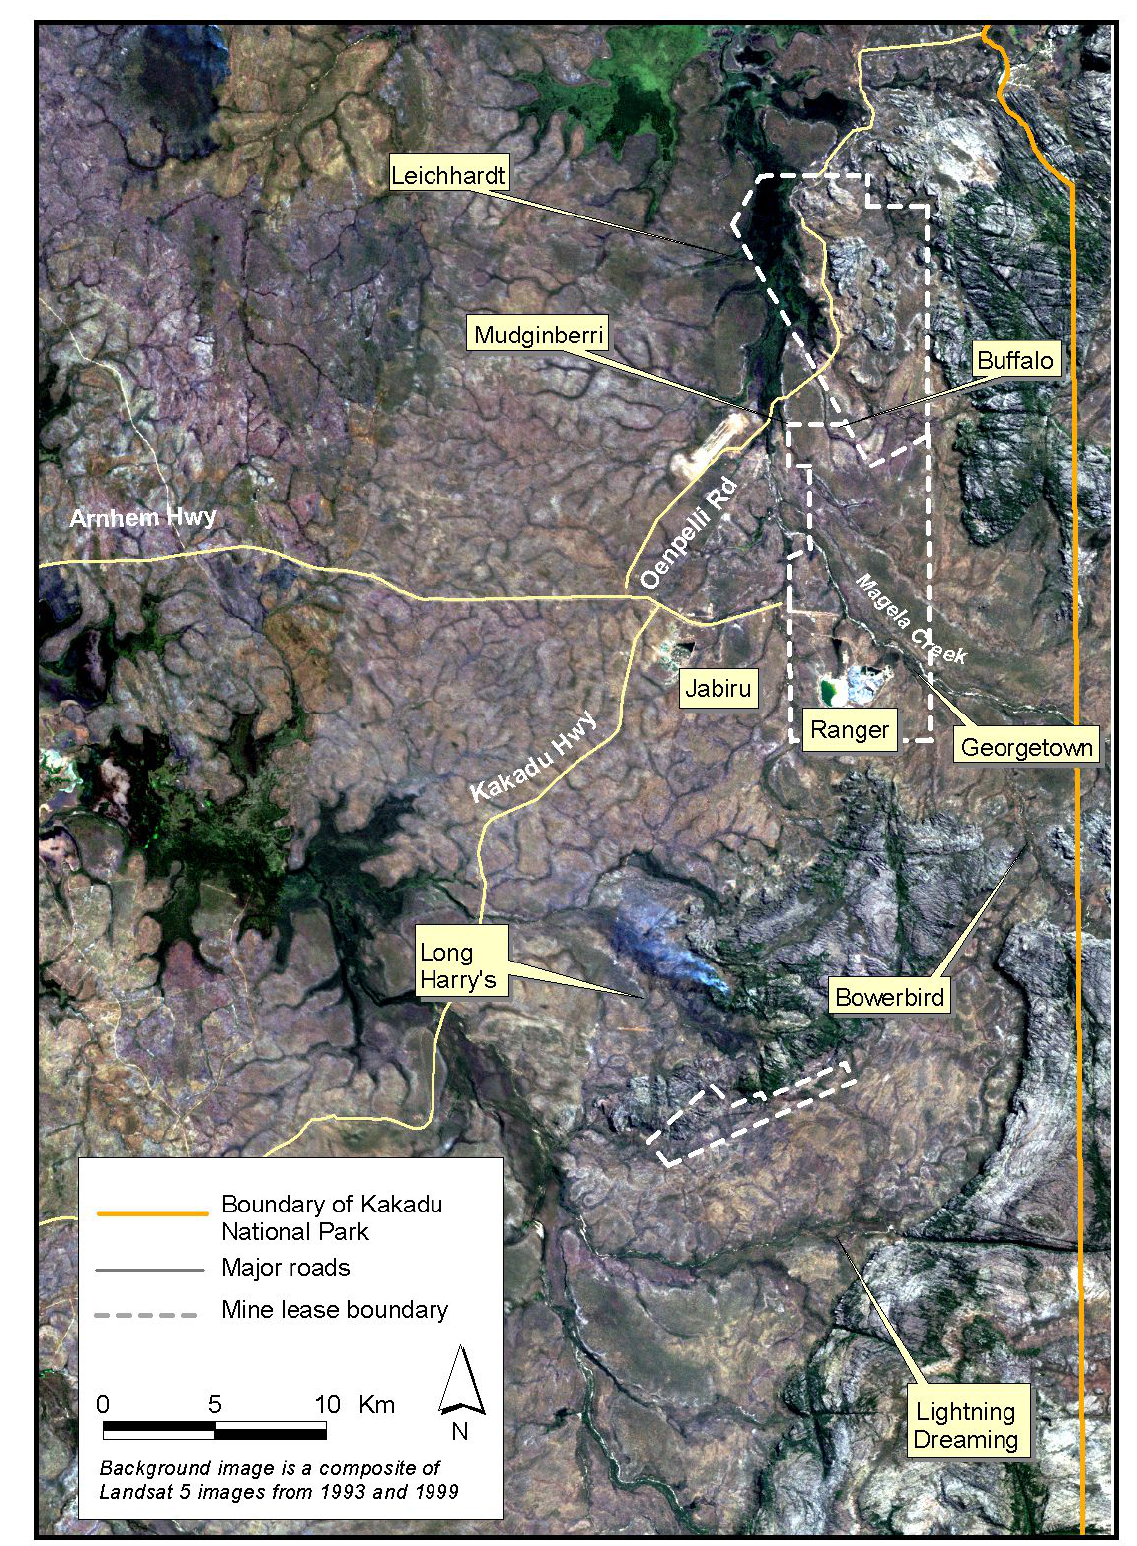
FIGURE 3. The region around the Ranger uranium